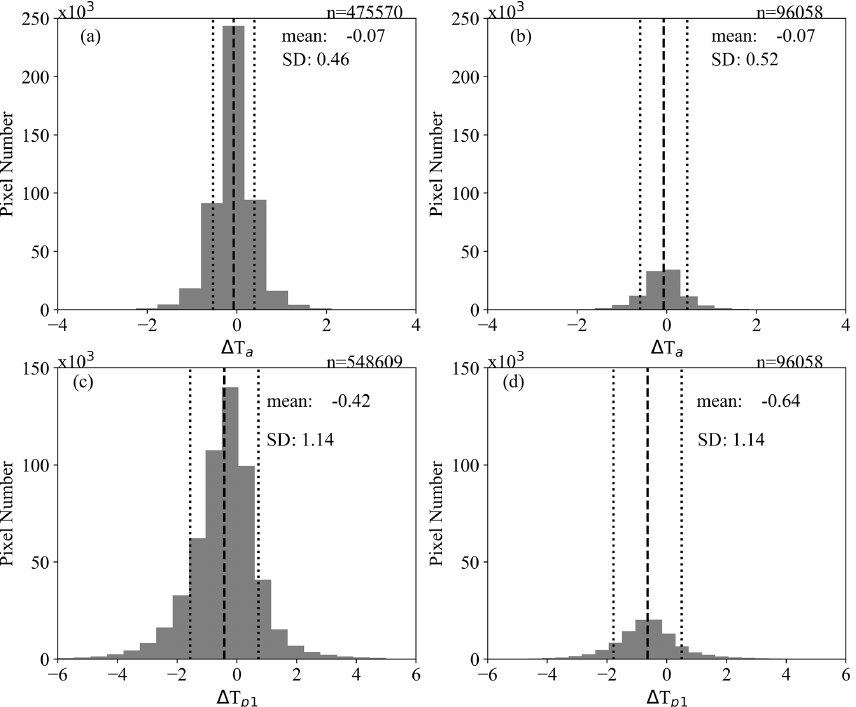
Figure A2. (a) Histogram of (cid:49)T a of all pixels based on the GFC dataset. (b) Histogram of (cid:49)T a for samples used for the statistical test. (c) Histogram of (cid:49)T p of all pixels based on the GFC dataset. (d) Histogram of (cid:49)T p 1